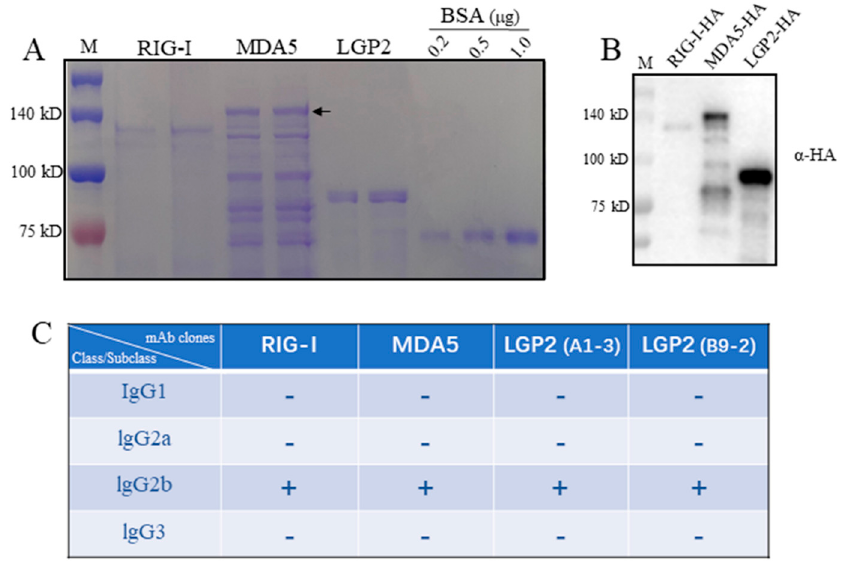
Figure 1. The porcine RLR purified proteins and the isotypes of four monoclonal antibodies against RLRs. ( A ) The purified proteins of porcine RLRs, RIG-I, MDA5 and LGP2, together with control BSA protein were subjected to SDS-PAGE and stained with Coomassie brilliant blue. The arrow head indicates the full-length MDA5. ( B ) The pRIG-I, pMDA5 and pLGP2 proteins were subjected to SDS-PAGE, transferred to PVDF membrane and detected by immunoblotting with anti-HA mAb. The protein markers are labeled on the left. ( C ) With the mouse monoclonal antibody Ig class/subtype identification kit, 4 strains of porcine RLR monoclonal antibodies derived from ascites all belong to IgG2b.